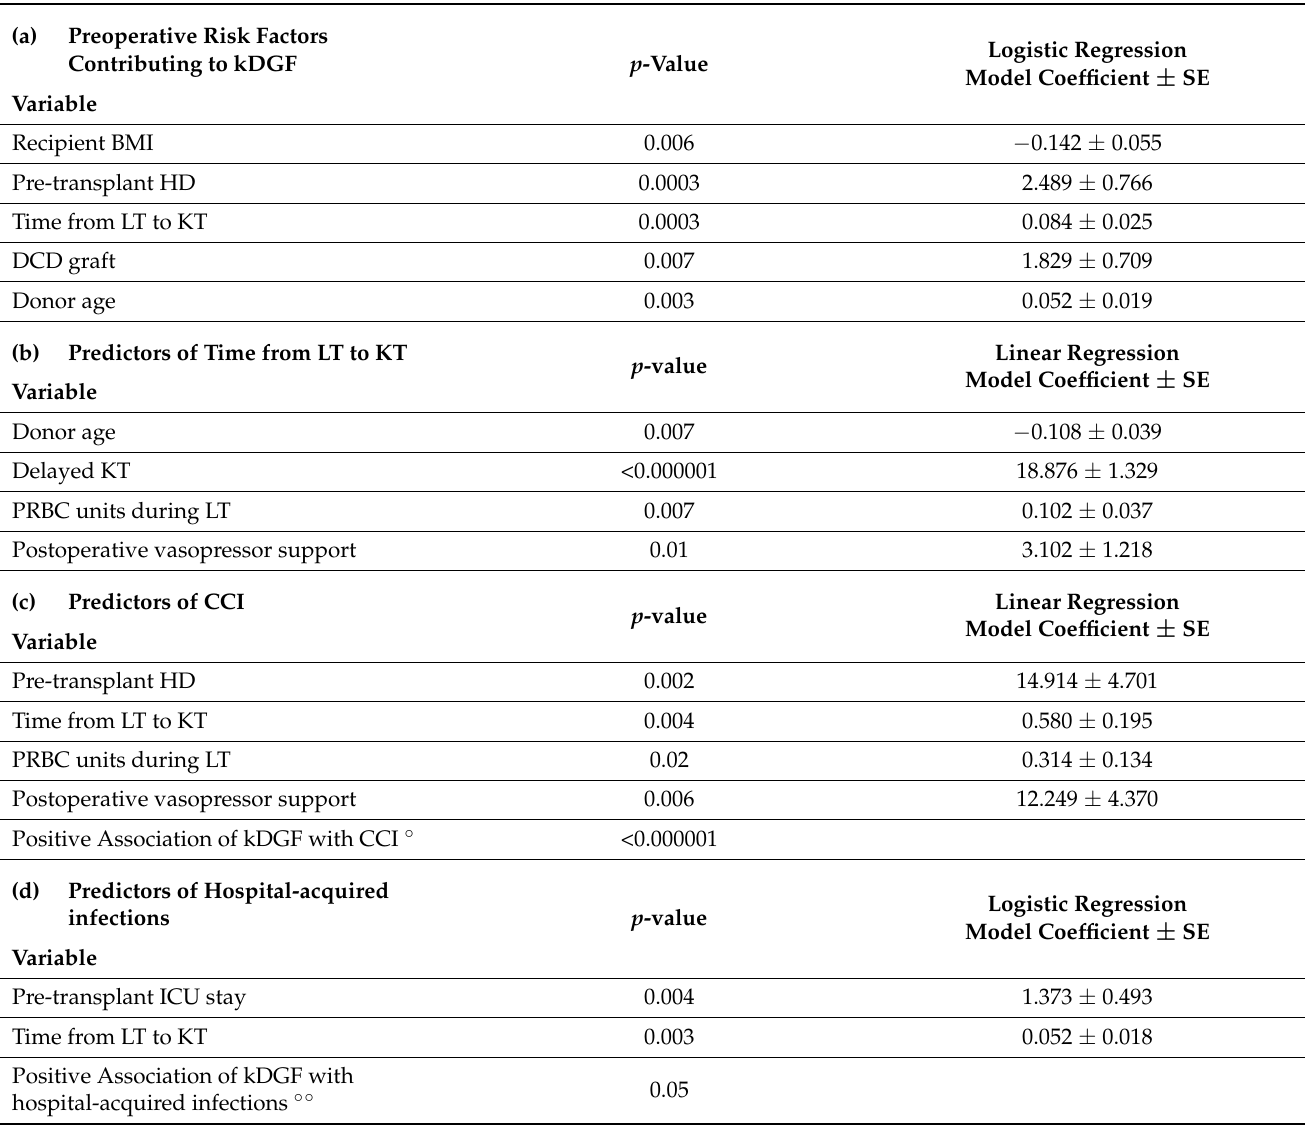
Table 5. Multivariable Analysis